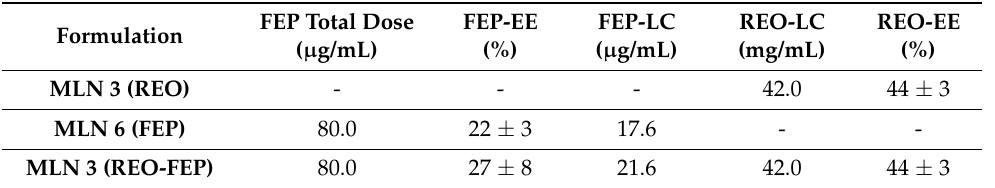
Table 5. Loaded concentrations of REO and FEP in MLN 3 and MLN 6.